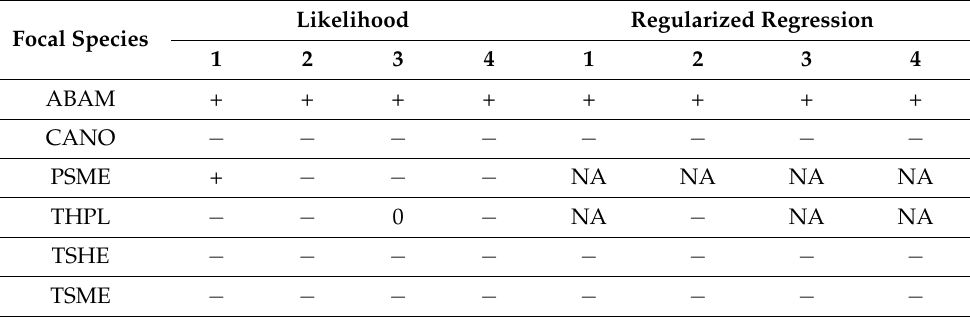
Table 2. Is focal growth higher in the presence of conspecific or heterospecific neighbors? Higher growth in the presence of conspecifics represents positive feedback on growth and is indicated with ‘+’. Negative feedback and the absence of feedback are indicated with ‘ − ’ and ‘0’, respectively. NA values for regularized regression indicate that the model did not find growth to be substantially higher in the presence of conspecifics or heterospecifics. See Table S16 for numerical outputs. Likelihood Regularized Regression Focal Species 1 2 3 4 1 2